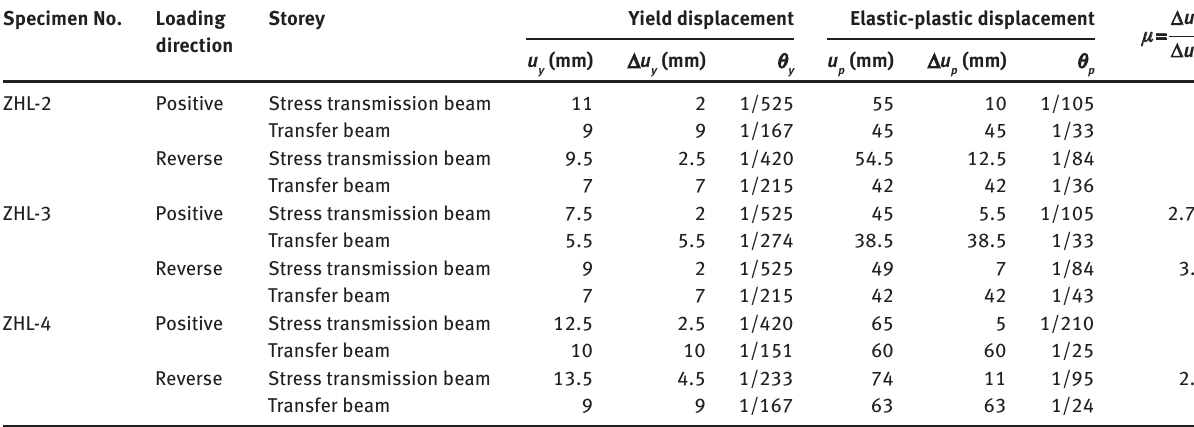
Table 5: The measured positive and negative displacement and ductility factor of the specimens. Specimen